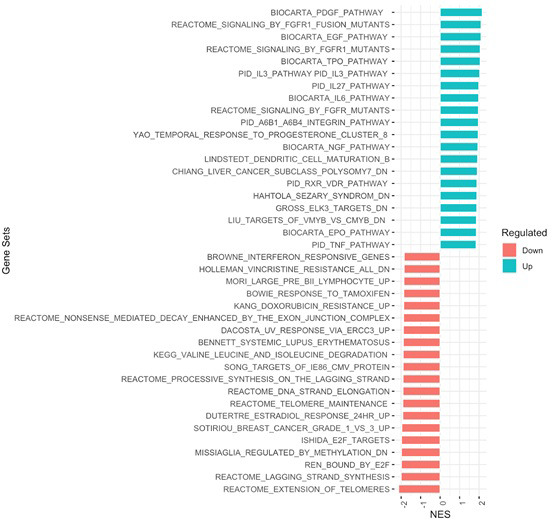
Gene set enrichment analysis (GSEA) of genes with differential response to glucose between individuals with diabetes with and without diabetic retinopathy.Normalized enrichment score (NES). Source files for this plot can be found in Gene Expression Omnibus (GEO) at https://www.ncbi.nlm.nih.gov/geo/ under accession code GSE146615.